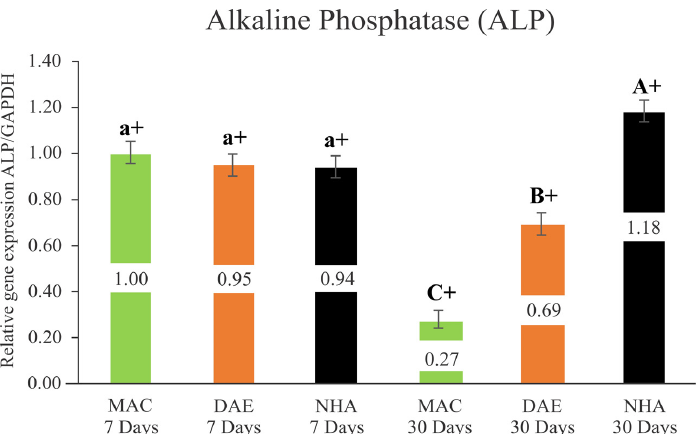
Figure 5. Relative expression of alkaline phosphatase/GAPDH (ALP/GAPDH) in all groups (mean +95% confidence interval). Lower case letters represent the analysis of 7 days, and capital letters the analysis of 30 days. Different letters indicate a statistically significant difference between groups. The + sign indicates a statistically significant difference (MAC: p < 0.001; DAE: p < 0.001; NHA: p < 0.001) for intragroup analyses, considering the same surface treatment and different assessment times.